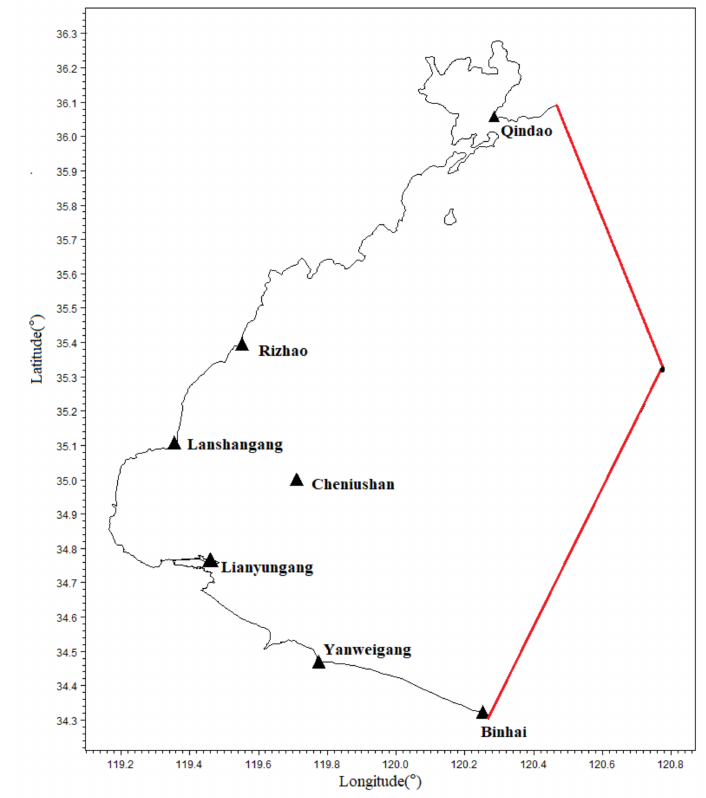
Figure 2. Study area and distribution of coastal tide